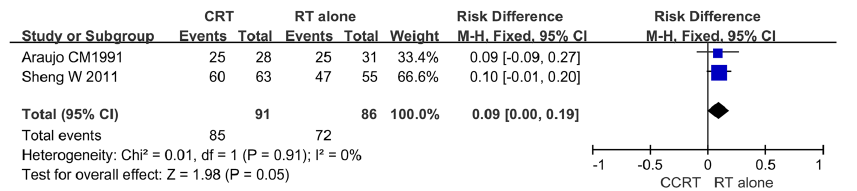
Fig 1. Forest plot comparing primary tumor response rates for the CCRT group and the RT alone group. The blue squares represent study-specific risk difference (RD), the horizontal line represents 95% confidence intervals (CIs), and the black diamond represents summary risk difference.